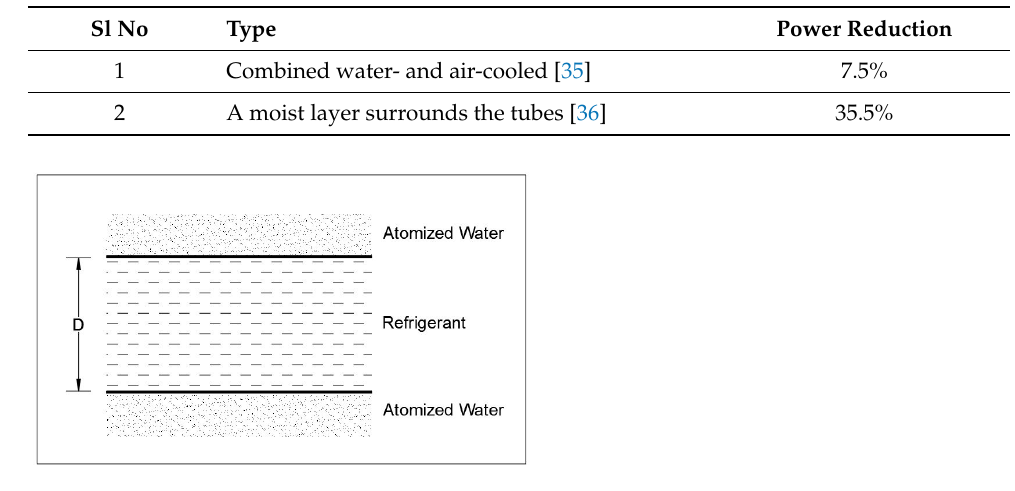
Figure 6. Vaporized water around the tube.